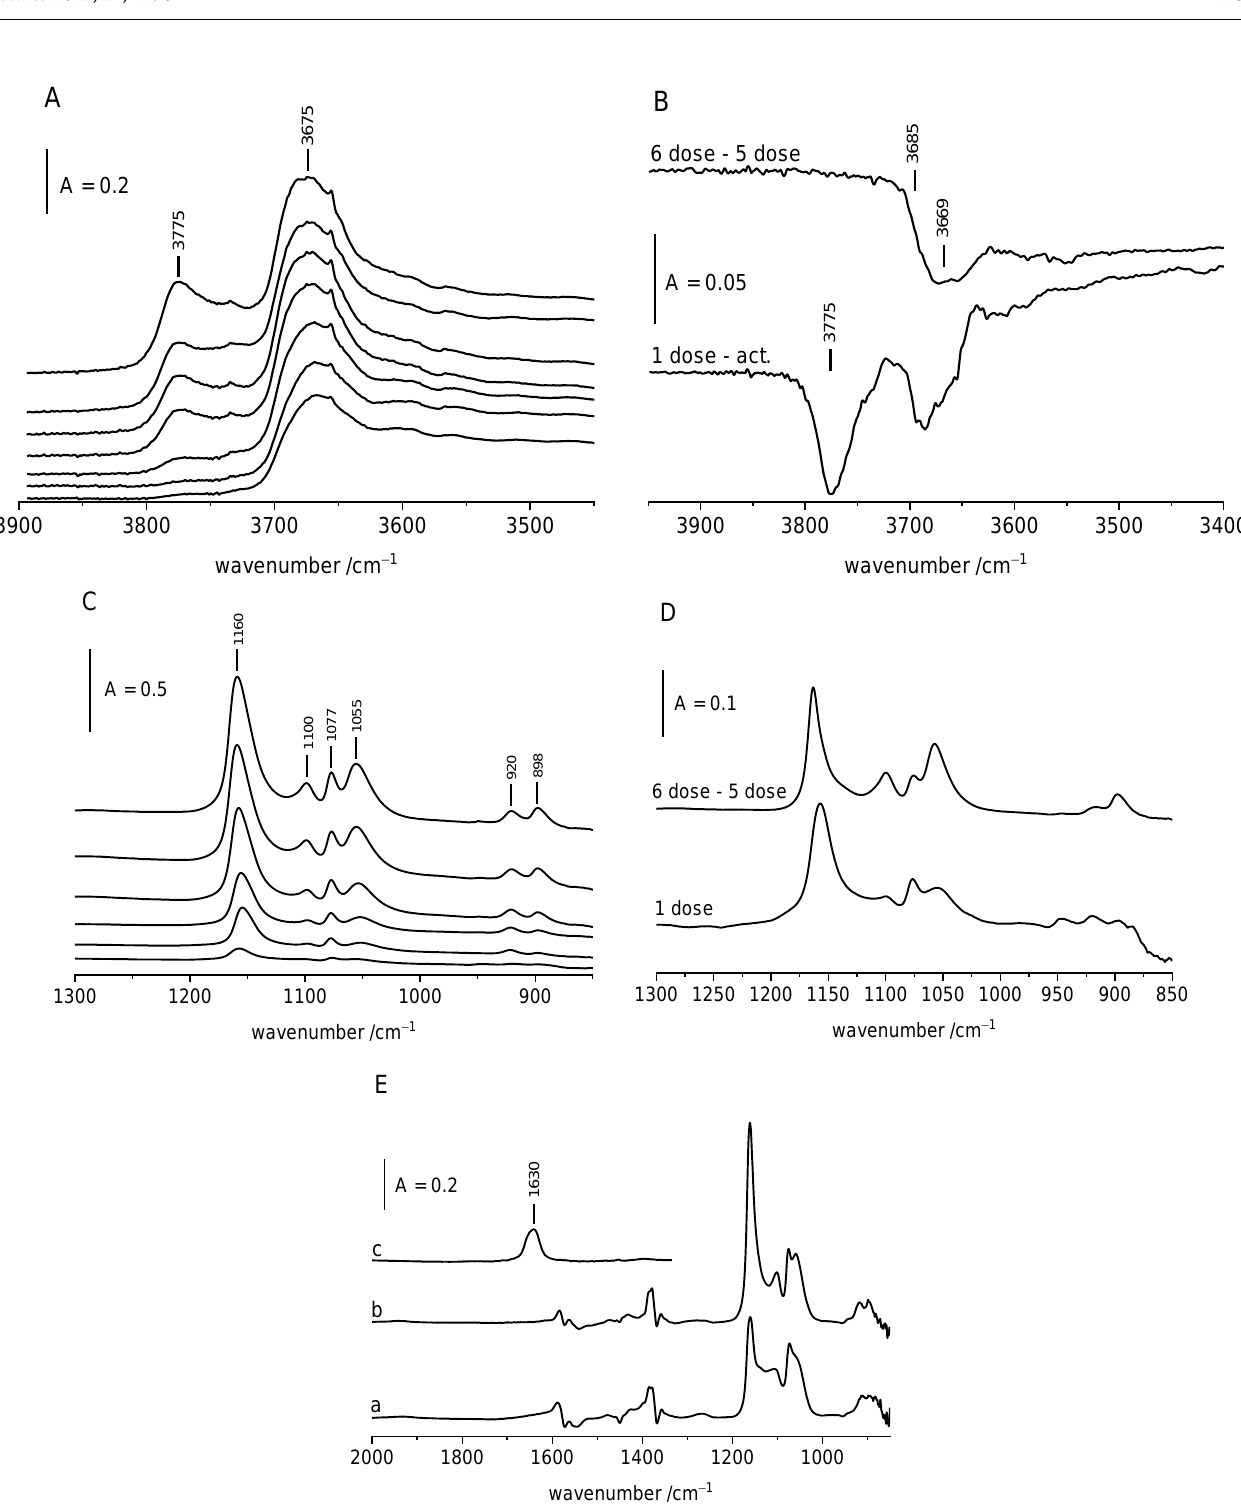
Figure 2. ( A ) — The spectra of OH groups on ZrO 2 upon adsorption of ethanol (from bottom to top increasing loading of ethanol). Each spectrum was recorded upon the adsorption of one dose of ethanol (ca. 5 µmol of ethanol/100 mg of ZrO 2 . ( B ) — OH groups on ZrO 2 , difference spectra: activated ZrO 2 minus 1st dose of ethanol and 6th dose minus 5th dose. ( C ) — alkoxy groups on ZrO 2